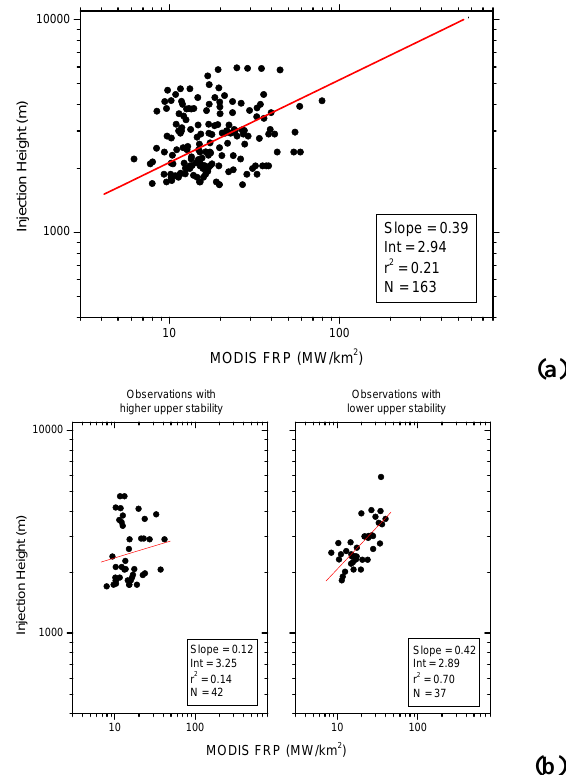
Fig. 7. (a) Log-log scatter-plot of Fire Power versus smoke Injec- tion Height. The continuous red line is the regression line of the data set. (b) Log-log scatter-plot of Fire Power versus smoke In- jection Height in the case of the presence of stable layers in the free troposphere (left panel) and when the free troposphere showed almost neutral atmospheric stability conditions (right